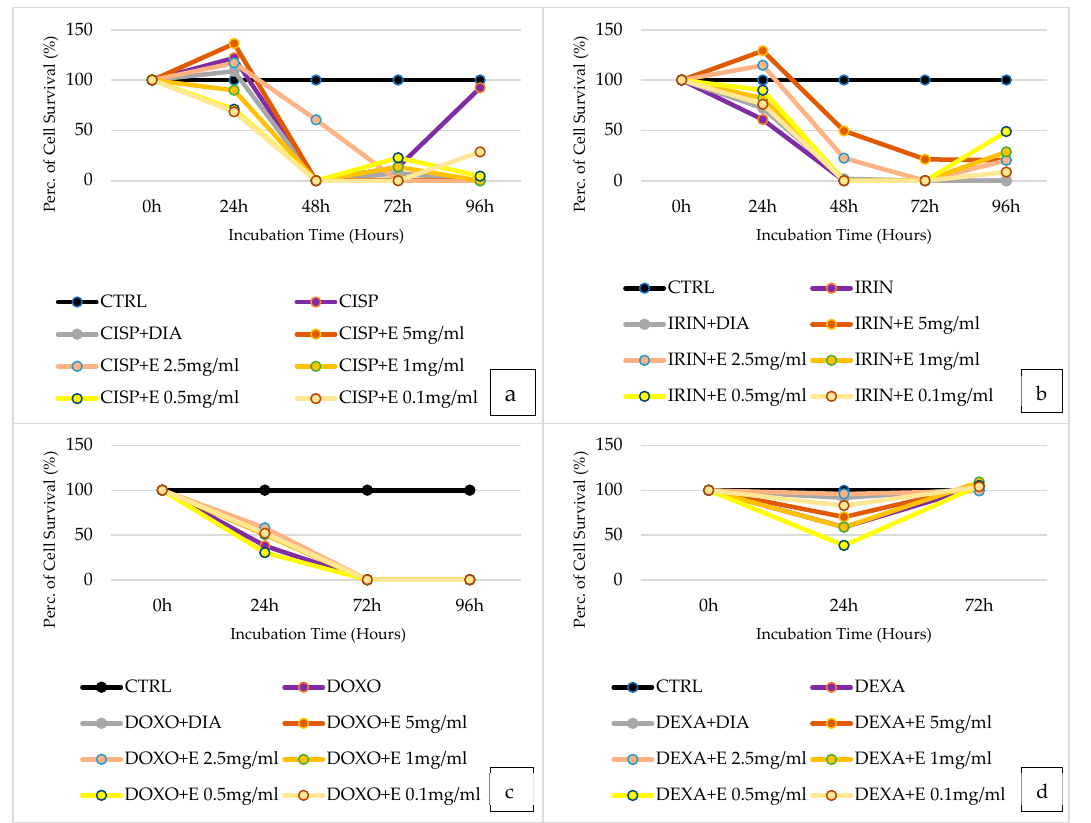
Figure 8. ( a ) Percentage of cell growth values of SHSY5Y cells co-incubated with cisplatin (CISP), cisplatin and diazoxide (CISP + DIA), and cisplatin and various concentrations of the extract (CISP + E) measured using the crystal violet assay, compared to controls (CTRL). Data are shown for various concentrations of the extract (5 mg/mL, 2.5 mg/mL, 1 mg/mL, 0.5 mg/mL, and 0.1 mg/mL) after 0 h, 24 h, 48 h, 72 h, and 96 h of incubation, using the drug cisplatin (CISP) in the purple lines, cisplatin and diazoxide (CISP + DIA) in gray lines, and cisplatin with the various concentrations of the extract (CISP + E) in orange and yellow lines. ( b ) Percentage of cell growth values of SHSY5Y cells co-incubated with irinotecan (IRIN), irinotecan and diazoxide (IRIN + DIA), and irinotecan and various concentrations of the extract (IRIN + E) measured using the crystal violet assay, compared to controls (CTRL). Data are shown for various concentrations of the extract (5 mg/mL, 2.5 mg/mL, 1 mg/mL, 0.5 mg/mL, and 0.1 mg/mL) after 0 h, 24 h, 48 h, 72 h, and 96 h of incubation, using the drug irinotecan (IRIN) in the purple lines, irinotecan and diazoxide (IRIN + DIA) in gray lines, and irinotecan with the various concentrations of the extract (IRIN + E) in orange and yellow lines. ( c ) Percentage of cell growth values of SHSY5Y cells co-incubated with doxorubicin (DOXO), doxorubicin and diazoxide (DOXO + DIA), and doxorubicin and various concentrations of the extract (DOXO + E) measured using the crystal violet assay, compared to controls (CTRL). Data are shown for various concentrations of the extract (5 mg/mL, 2.5 mg/mL, 1 mg/mL, 0.5 mg/mL, and 0.1 mg/mL) after 0 h, 24 h, 48 h, 72 h, and 96 h of incubation, using the drug doxorubicin (DOXO) in the purple lines, doxorubicin and diazoxide (DOXO + DIA) in gray lines, and doxorubicin with the various concentrations of the extract (DOXO + E) in orange and yellow lines. ( d ) Percentage of cell growth values of SHSY5Y cells co-incubated with dexamethasone (DEXA), dexamethasone and diazoxide (DEXA + DIA), and dexamethasone and various concentrations of the extract (DEXA + E) measured using the crystal violet assay, compared to controls (CTRL). Data are shown for various concentrations of the extract (5 mg/mL, 2.5 mg/mL, 1 mg/mL, 0.5 mg/mL, and 0.1 mg/mL) after 0 h, 24 h, and 72 h of incubation, using the drug dexamethasone (DEXA) in the purple lines, dexamethasone and diazoxide (DEXA + DIA) in gray lines, and dexamethasone with the various concentrations of the extract (DEXA + E) in orange and yellow